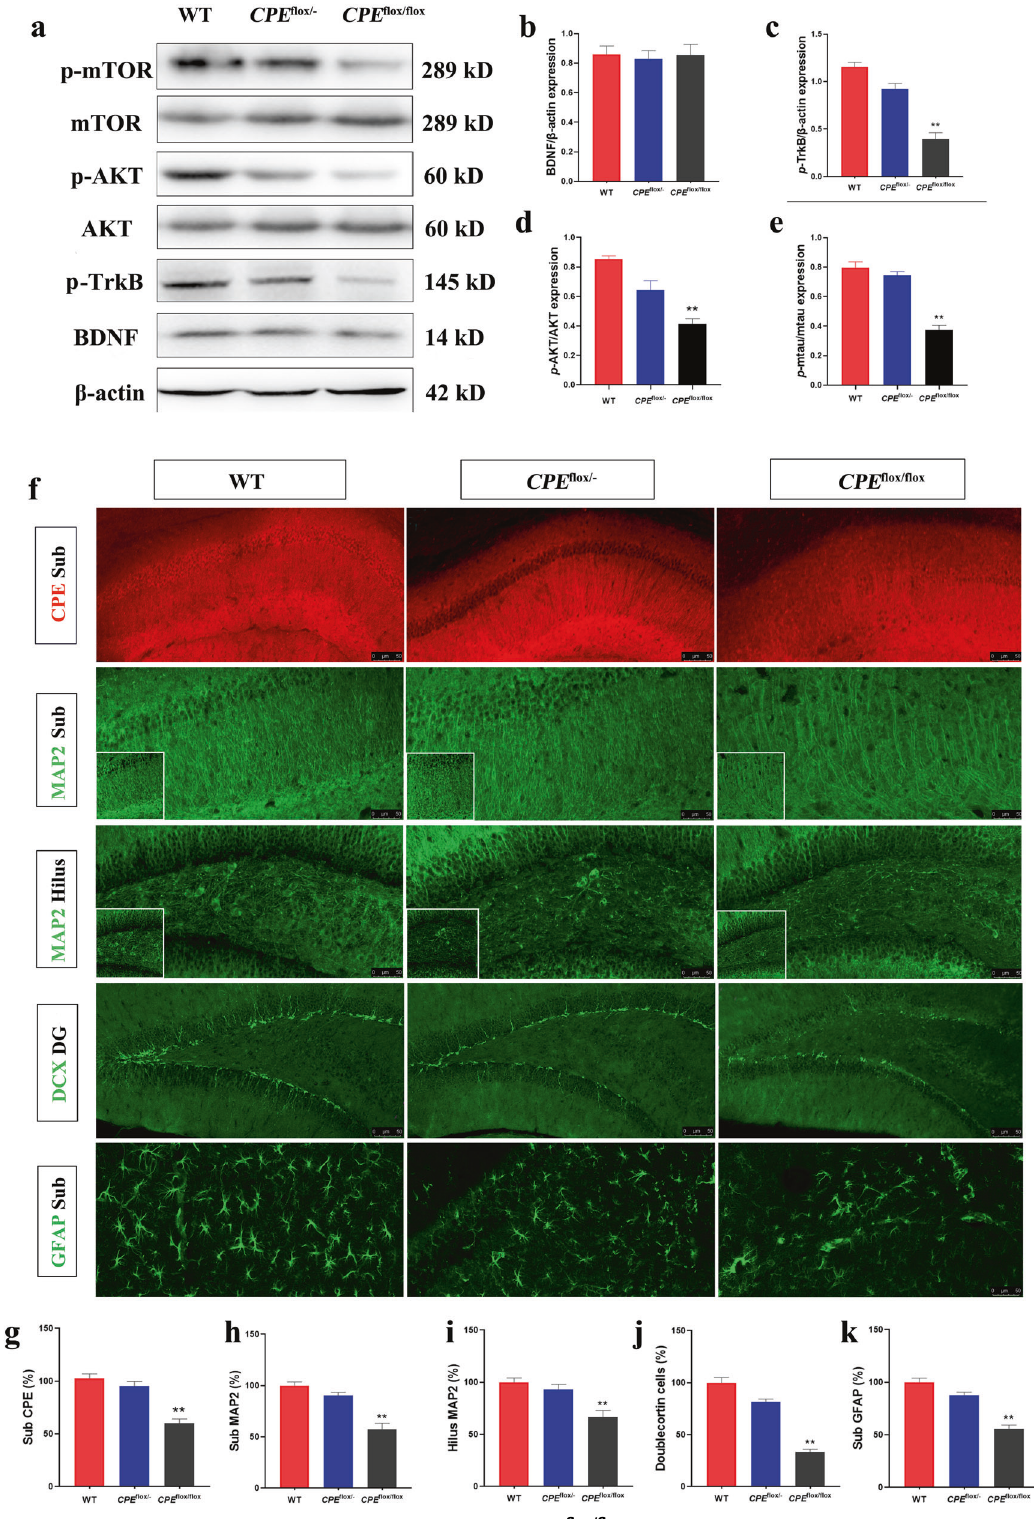
Fig. 4 Decreased hippocampal dentate gyrus (DG) neurogenesis in CPE fl ox/ fl ox mice. a – e Western blot analysis of p -TrkB, BDNF, p -mTOR, mTOR, p -AKT, and AKT levels in the hippocampus. f Immuno fl uorescence of CPE, MAP2, DCX, and GFAP; and the relative fl uorescent intensities of g CPE in Sub, h MAP2 in Sub, i MAP2 in hilius, j DCX in DG, k GFAP in DG of WT, CPE fl ox/ − , and CPE fl ox/ fl ox mice at 100× and 400× (square in the panel). n = 6; * P < 0.05 and ** P < 0.01 compared with WT; values are mean ±